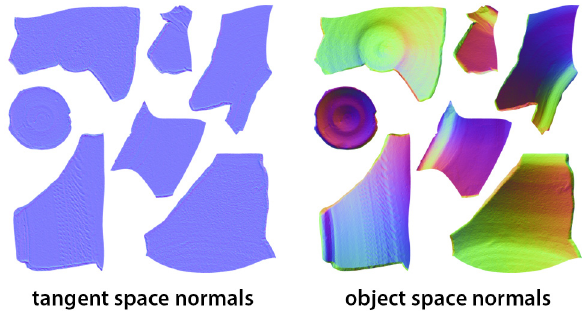
Figure 5. Tangent and object space normal maps.